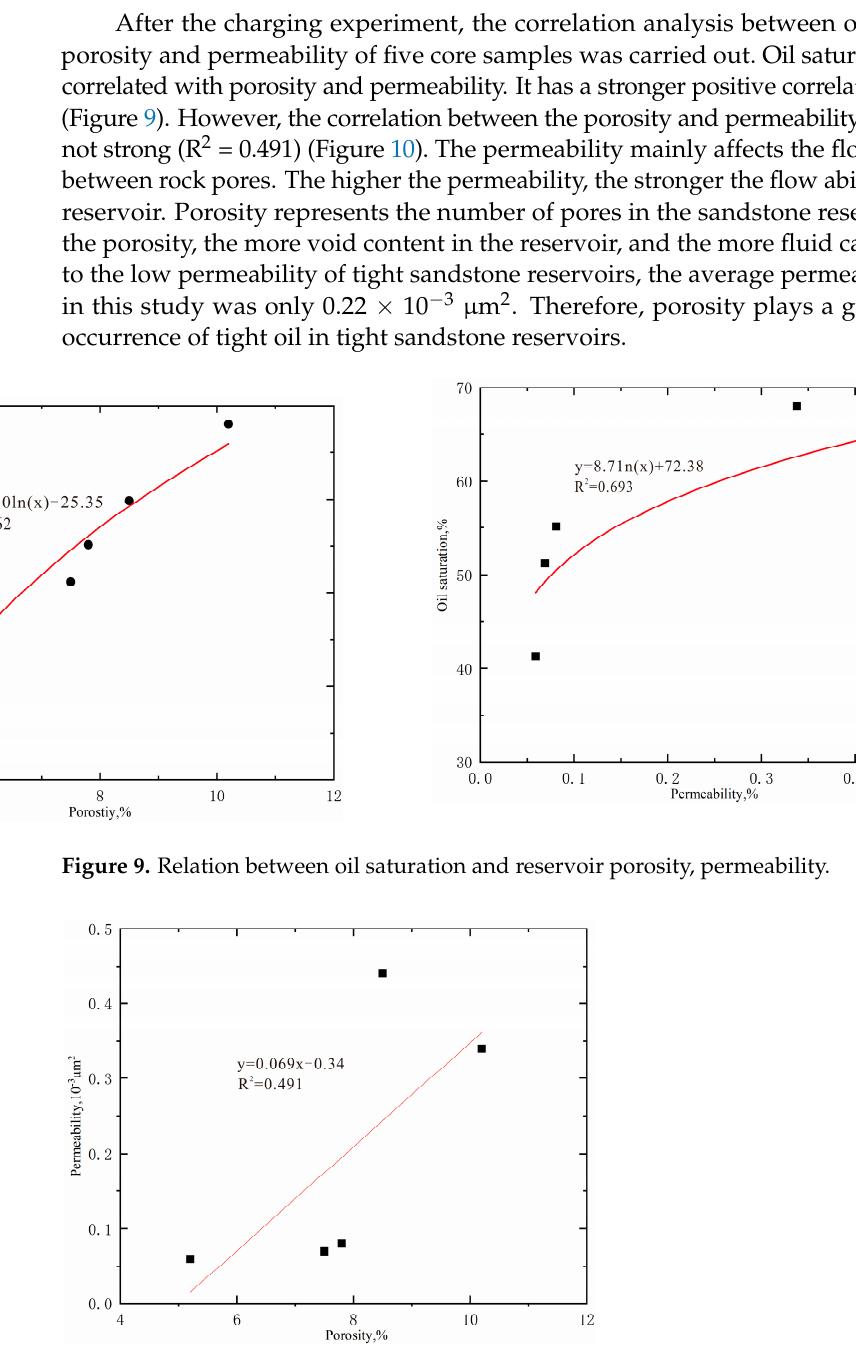
Figure 8. T 2 spectrum distribution of representative cores of Type III in the charging process and changes in oil saturation in different pores.